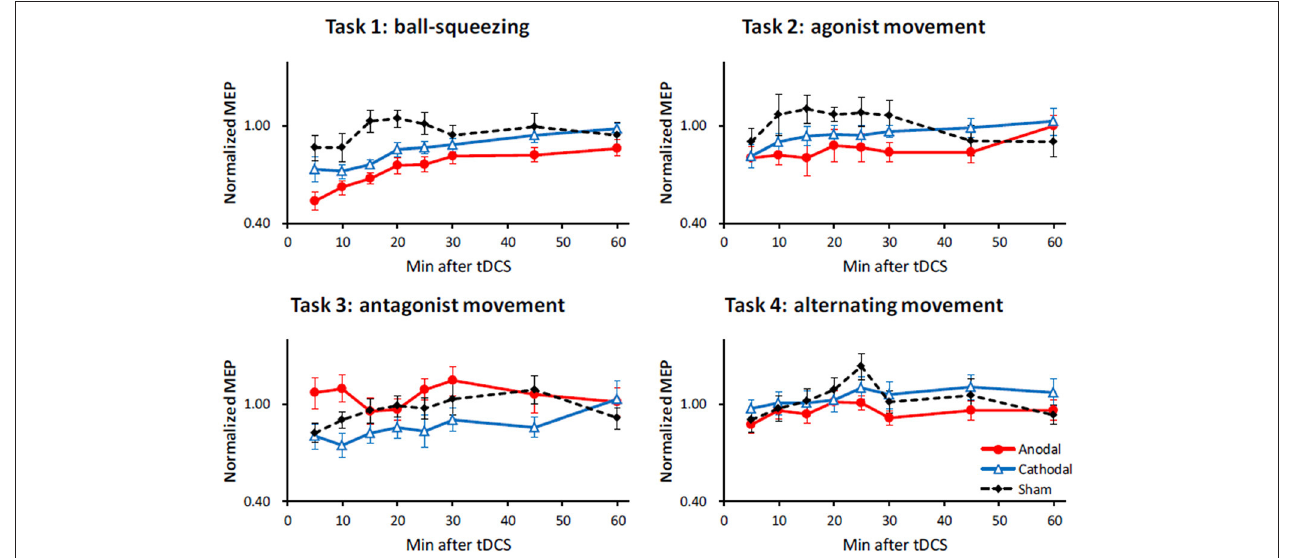
The X-axis represents time after tDCS in minutes, and Y-axis the normalized MEP amplitude. Error bars indicate standard error of the mean.